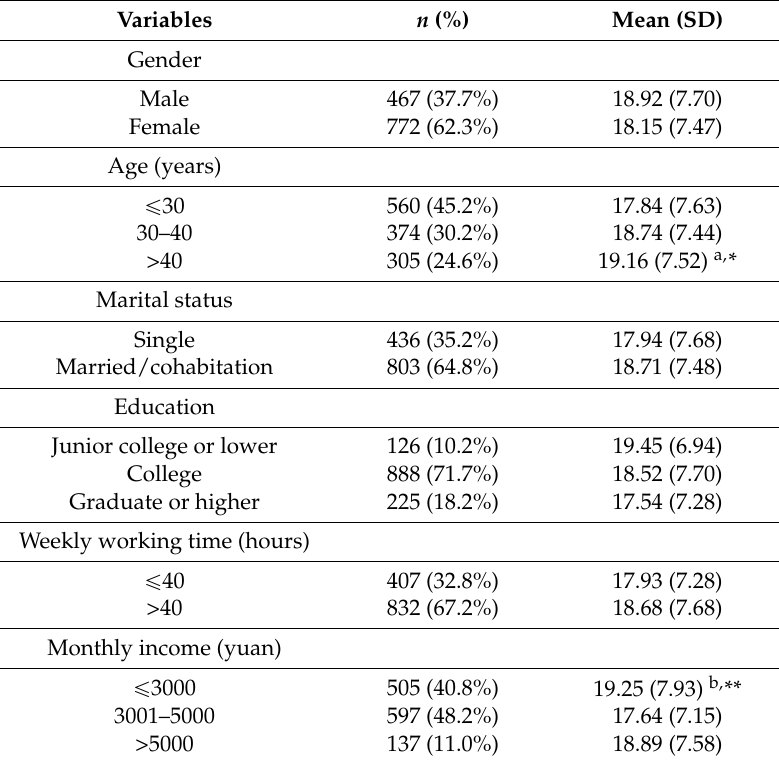
Table 1. Participant characteristics, means and standard deviations (SDs) of depressive symptoms ( n =